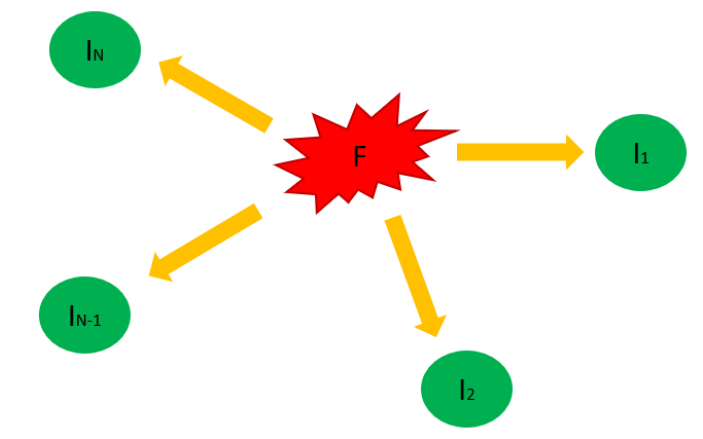
Figure 3. Common cause (F: Fire, Ii: Infrastructures, N: number of interdependent infrastructures).